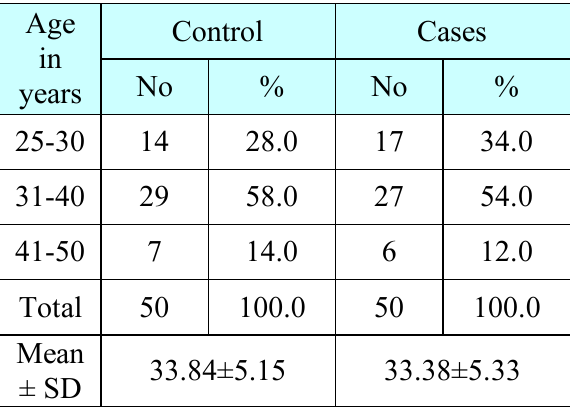
Table 1: Age distribution of subject studied